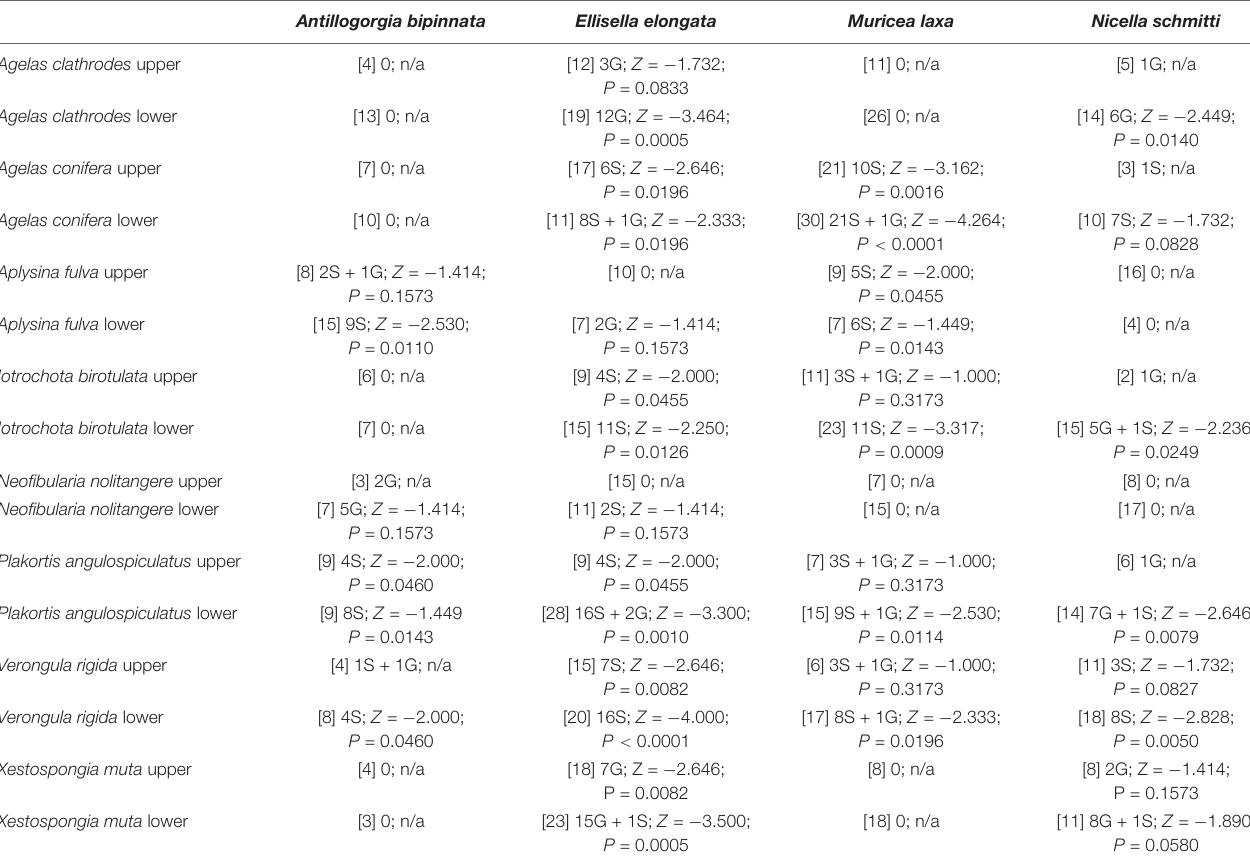
TABLE 1 | Contact interactions between gorgonians (top row) and sponges (left column) from five sites in the Caribbean Basin. Antillogorgia